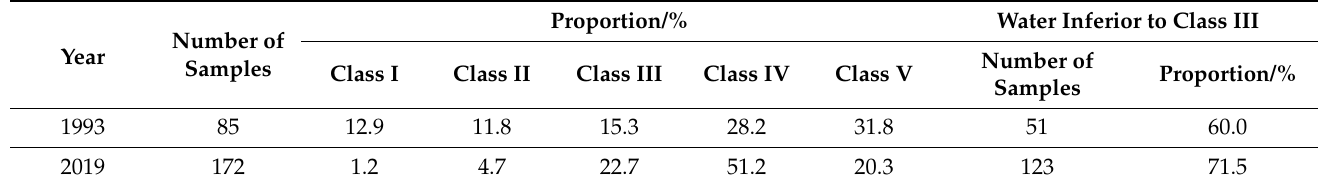
Table 2. Comparison of the evaluation results of groundwater quality between 1993 and 2019–2021.